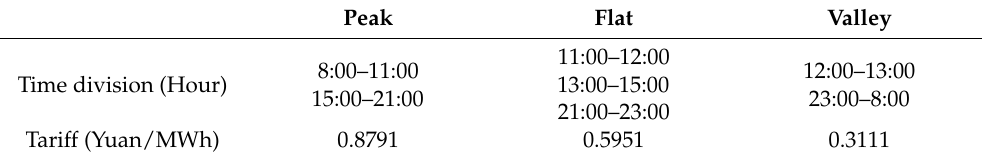
Table 2. The latest TOU tariff and PFV time division implemented by industrial users in the province. Peak Flat